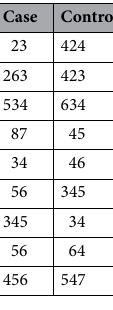
Table 1. An example contingency table for 2-SNV interaction of two SNVs: A and